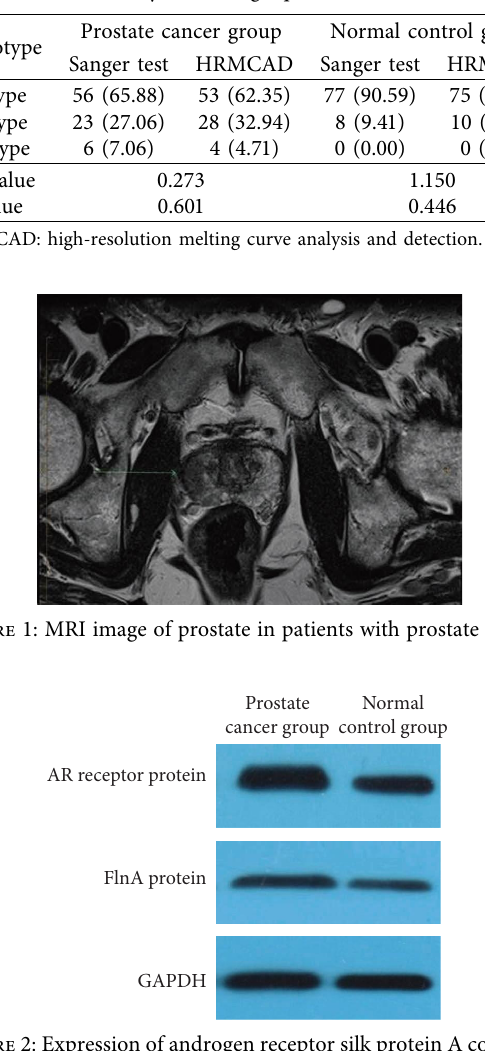
Table 3: Hardy–Weinberg equilibrium test ( n , %).